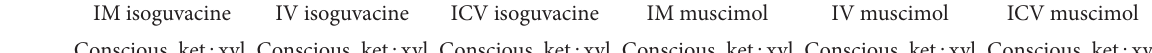
Table 1: Summary of GABAa agonist effects on the ERG and VEP in conscious and anaesthetised rats.